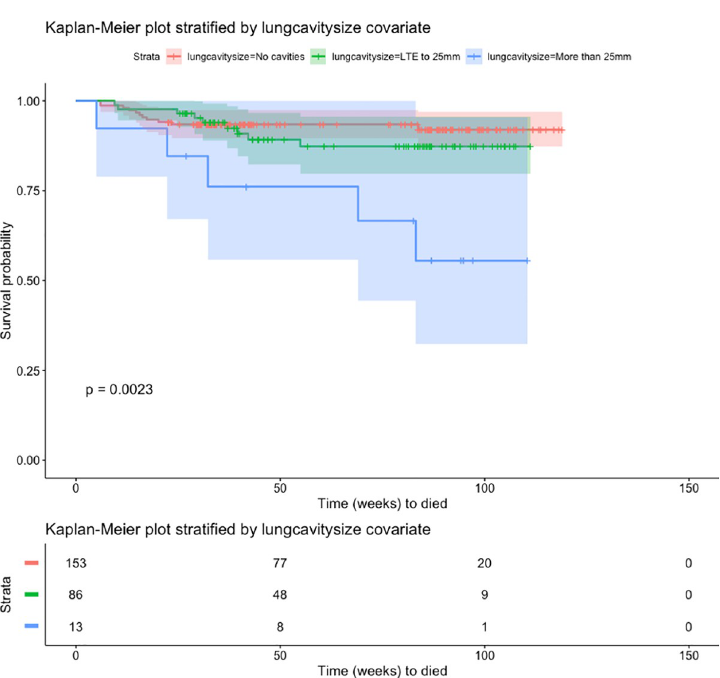
Fig 3. Kaplan-Meier curve showing probability of survival over time stratified by occurrence of radiologist annotation of observation of lung cavity size. Shaded area reflects the 95% confidence interval of each survival curve. The table show the number of cases at each time point. P-value shows the log-rank test comparing all survival curves.